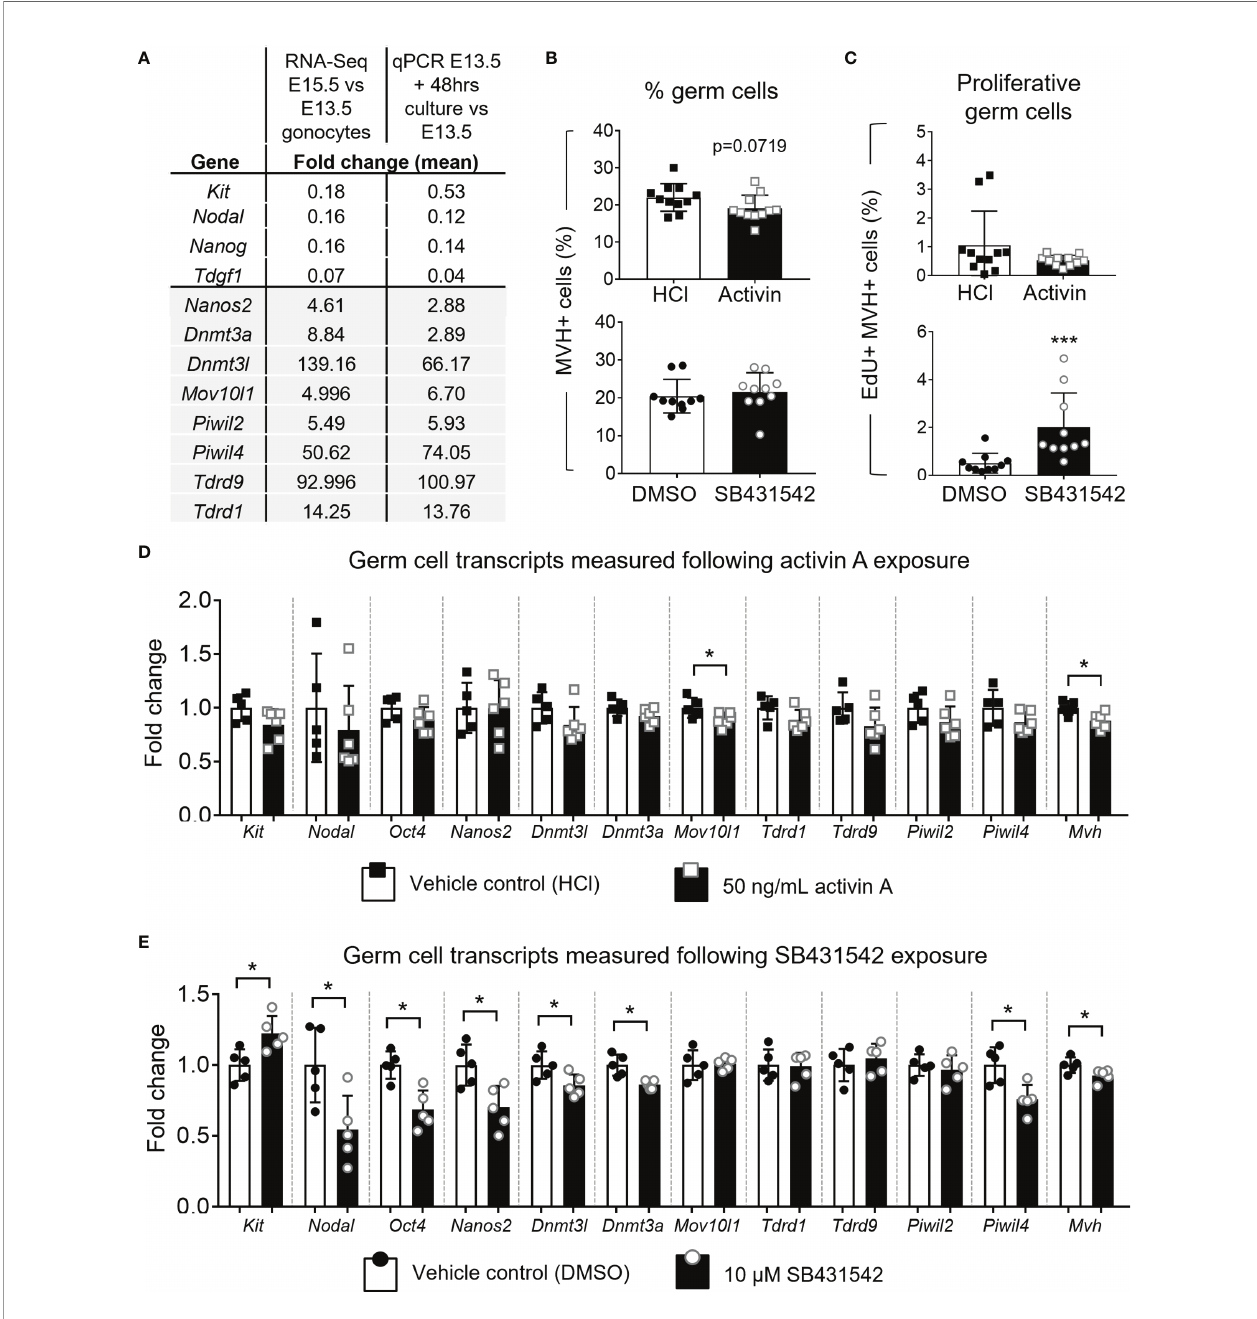
FIGURE 6 | Effect of acute activin A and SB431542 exposure on germ cells. E13.5 testes were cultured for 48 hours on membranes. (A) Table presents the fold change of transcript levels. The second column presents fold change of E15.5 compared to E13.5 germ cell transcripts measured by RNA-Sequencing (counts per million (CPM); n=3-4 animals per age). The third column represents the transcript fold-changes of E13.5 testes cultured under normal conditions for 48 hours compared with E13.5 testes measured by qRT-PCR (data was normalised to Canx ; n=5 per group). (B, C) Flow cytometry analysis of E13.5 testes cultured with 50 ng/mL activin A or 10 µM SB431542 for 48 hours compared with respective vehicle controls (HCl and DMSO). (B) Proportion of germ cells (MVH+ SOX9-) and (C) EdU-positive proliferating germ cells following culture with activin A or SB431542 (black columns) compared with controls (white columns). For activin A and controls, n=5 per group, for SB431542 and controls, n=5 and n=4 respectively. (D, E) qRT-PCR analysis of early germ cell and differentiation-associated markers in individual E13.5 testes cultured with (D) 50 ng/mL activin A (black bars; n=6) or HCl control (white bars; n=5) or (E) 10 µM SB431542 (black bars) or DMSO control (white bars; n=5 per group). Transcripts measured by qRT-PCR were normalised to Canx housekeeper and fold change compared to control group shown. All graphical data are presented as mean ± SD and signi fi cant differences determined by a Student ’ s t-test or Mann-Whitney test following the Shapiro-Wilk or D ’ Agostino and Pearson normality tests and indicated by asterisk (*p < 0.05, ***p <